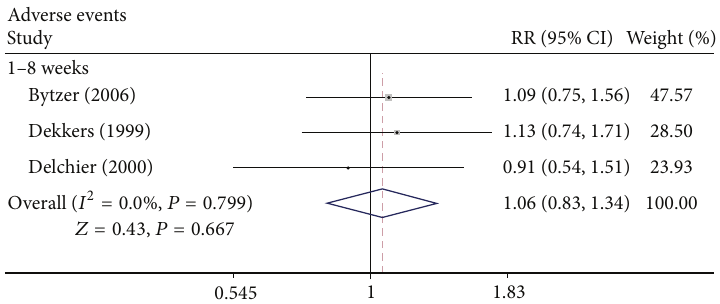
Figure 4: Adverse events of rabeprazole 20 mg once daily versus omeprazole 20mg once daily in the treatment of GERD. RR: relative risk; CI: confidence